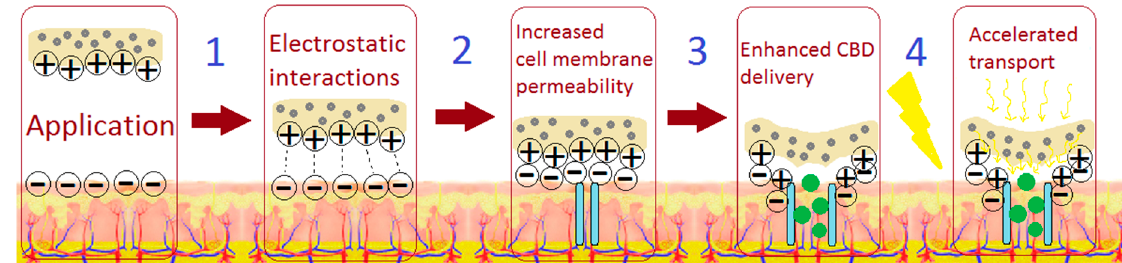
Figure 15. Possible applications of the stimuli-responsive transdermal systems in CBD delivery .